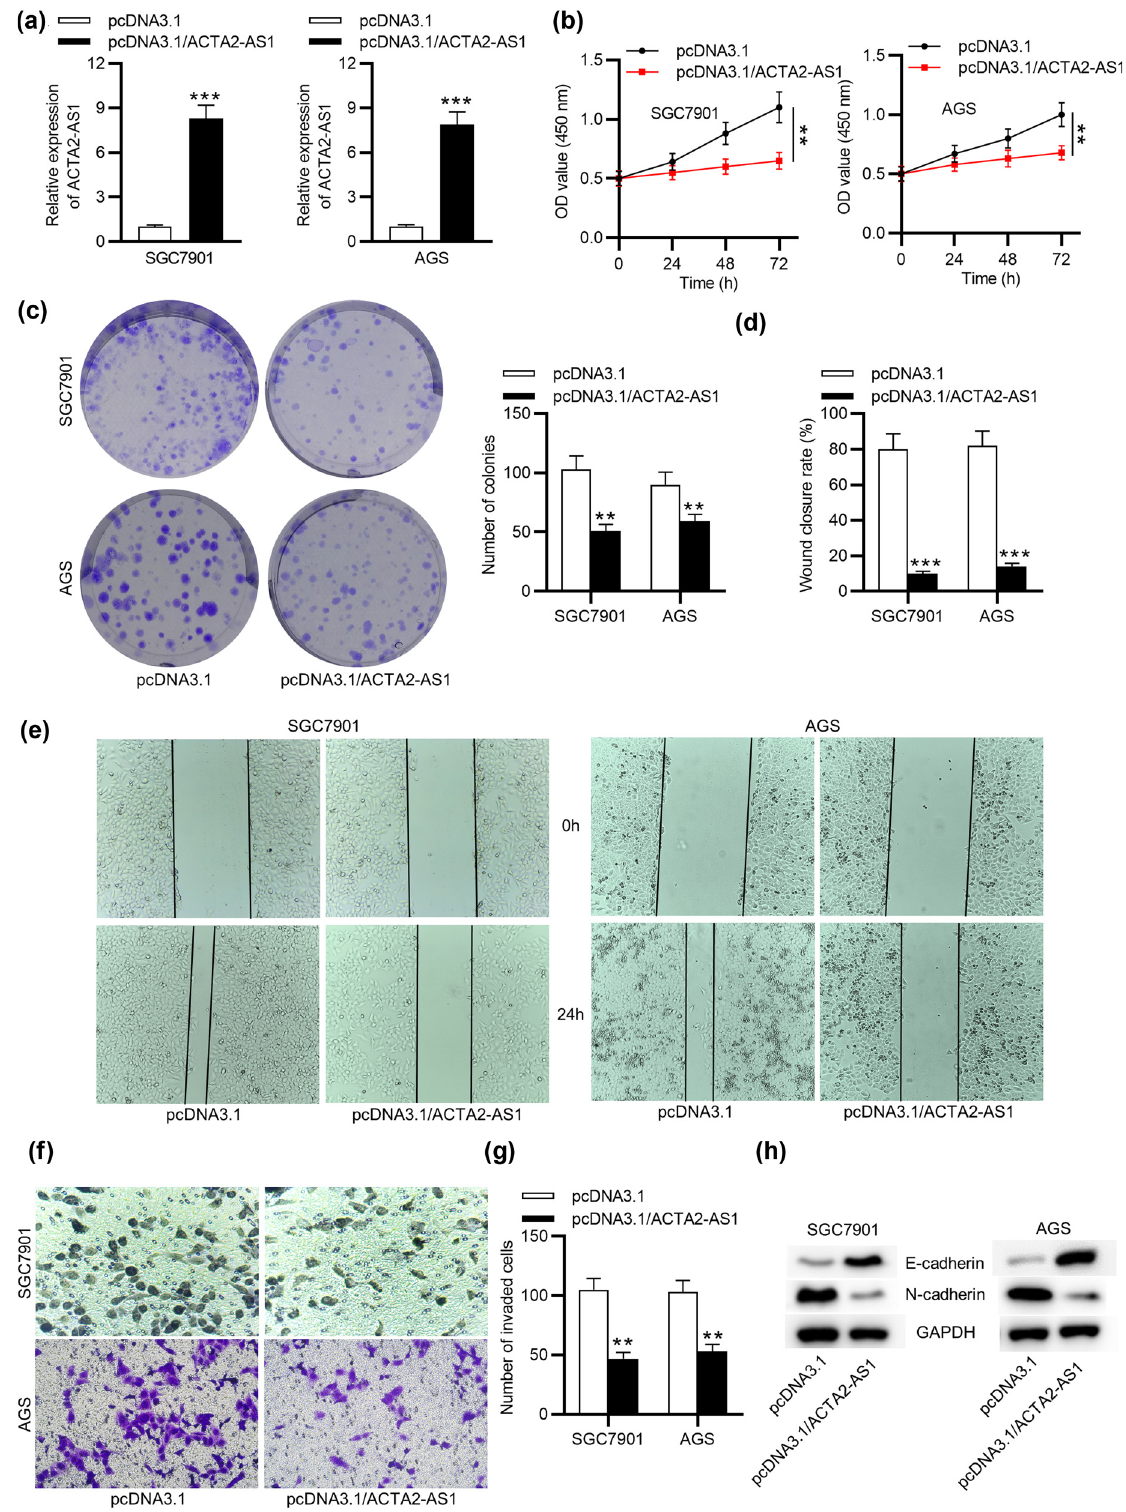
Figure 2: ACTA2 - AS1 overexpression inhibits GC cell proliferation, migration, invasion, and EMT process. ( a ) The overexpression e ffi ciency of pcDNA3.1/ACTA2 - AS1 in SGC7901 and AGS cells was detected by RT - qPCR. ( b ) CCK - 8 assays were performed to examine the e ff ect of ACTA2 - AS1 overexpression on GC cell viability. ( c ) Colony formation assay was applied to detect the proliferative capacity of GC cells after transfection of pcDNA3.1 or pcDNA3.1/ACTA2 - AS1. ( d – g ) Cell migration and invasion were, respectively, determined by wound healing assays and Transwell assays. ( h ) Protein levels of EMT markers were examined by Western blot analyses. ** p < 0.01 and *** p <